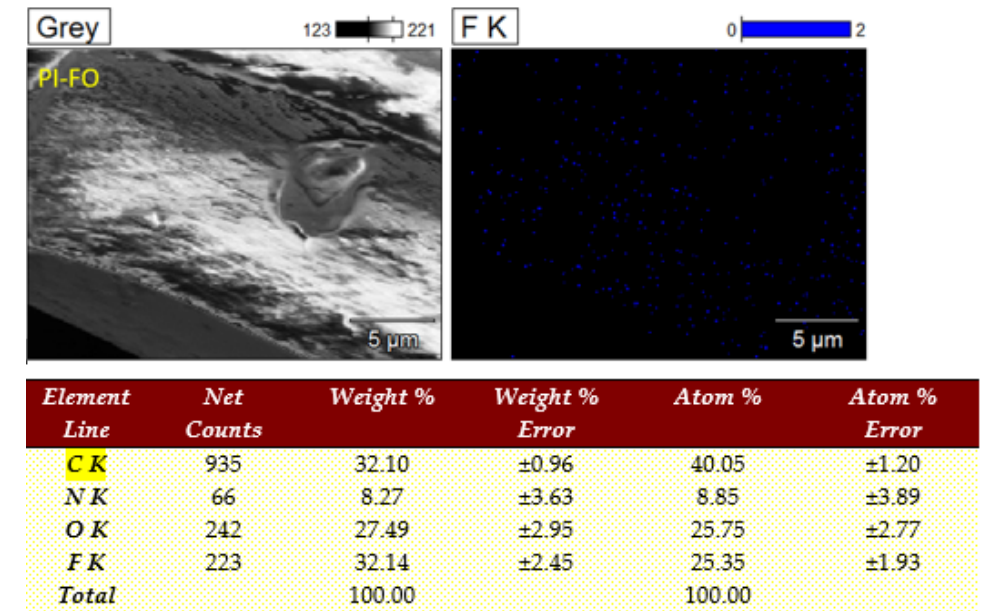
Figure 3. EDX of PI films.